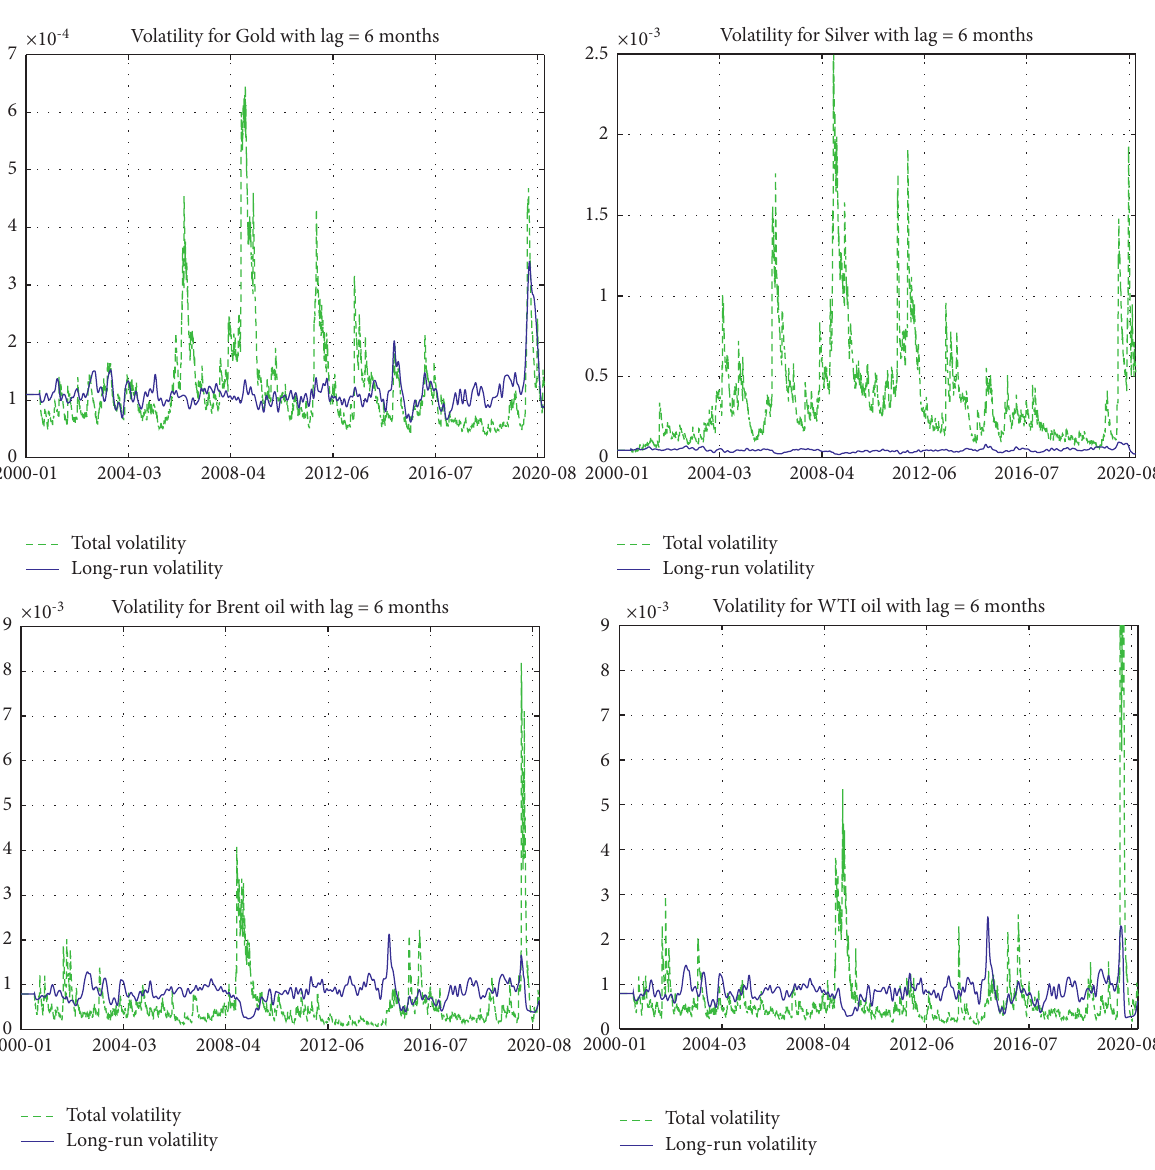
Figure 3: Estimated total and long-run volatility of precious metal and crude oil futures with GARCH-MIDAS+ RV+ID-EMV models. Table 6: Estimation results of GARCH-MIDAS +RV +ID-EMV models of futures volatility by infectious disease with 3-month lags.